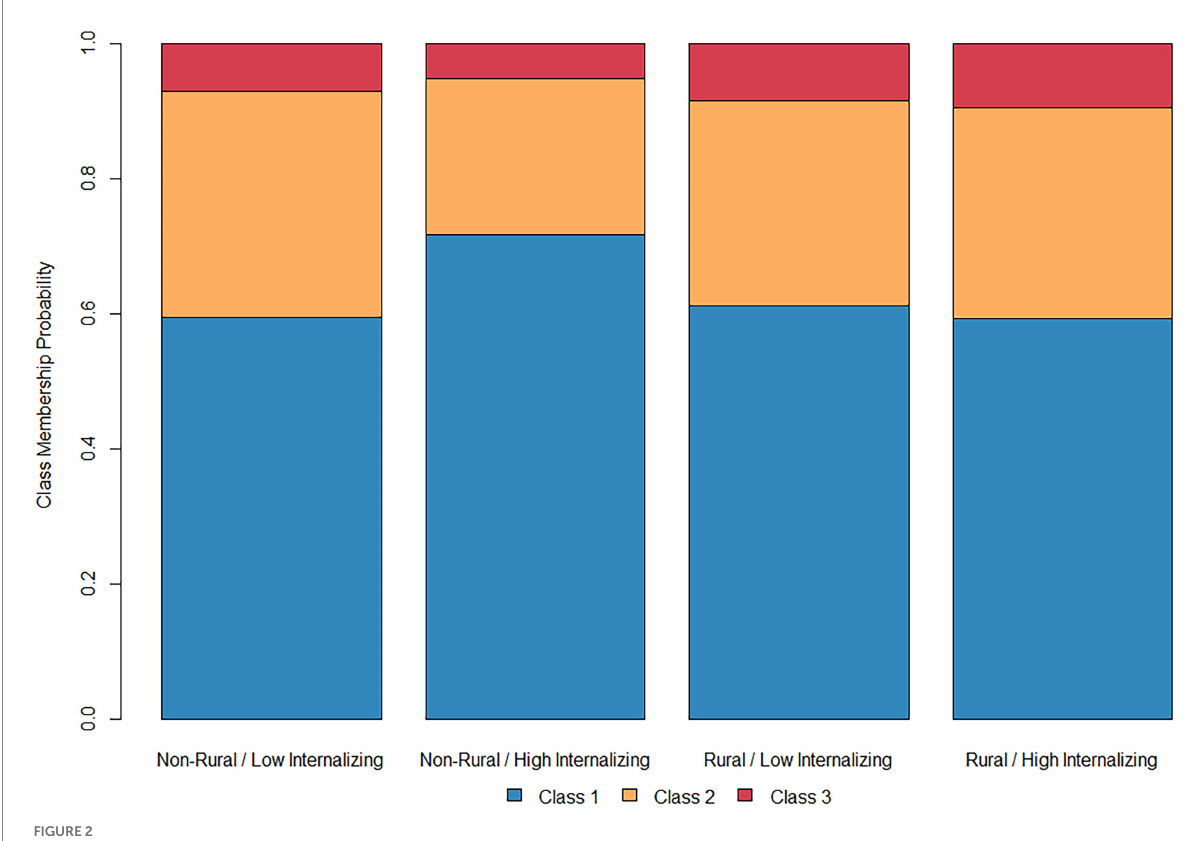
FIGURE 2 Class membership probability based on internalizing